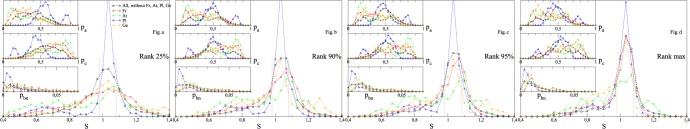
Histograms of involvement entropy, , with respect to the relative municipality-size bin over all analyzed since 2000.There are 12 French elections, 7 Austrian elections, 11 Polish elections, 7 German elections and 24 for others countries (included in one curve, with no more than 4 elections per country). Municipalities of each country are divided into bins (of  municipalities) with respect to their municipality-size (see e.g. Fig. 5). For instance, ‘Rank ’ (Fig. 8-a) means the bin whose population-size rank is the twenty-fifth per cent with regard to the sample of the most populated municipalities (Fig. 8-d) of the considered country. Insets: histograms of corresponding ,  and .  and  are plotted in dashed lines and all the scales axis are similar from one plot to another one.